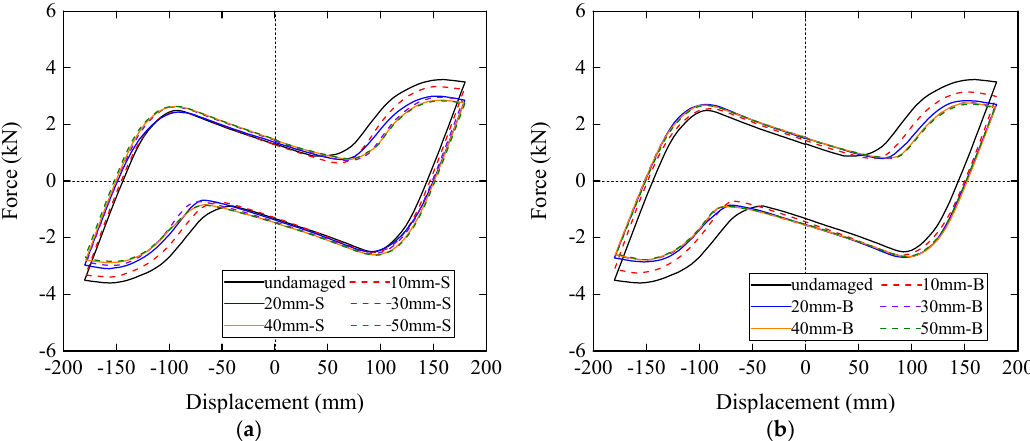
Figure 16. Hysteresis curves of the last cycle: ( a ) Single joint damaged models; ( b ) both joints damaged models.